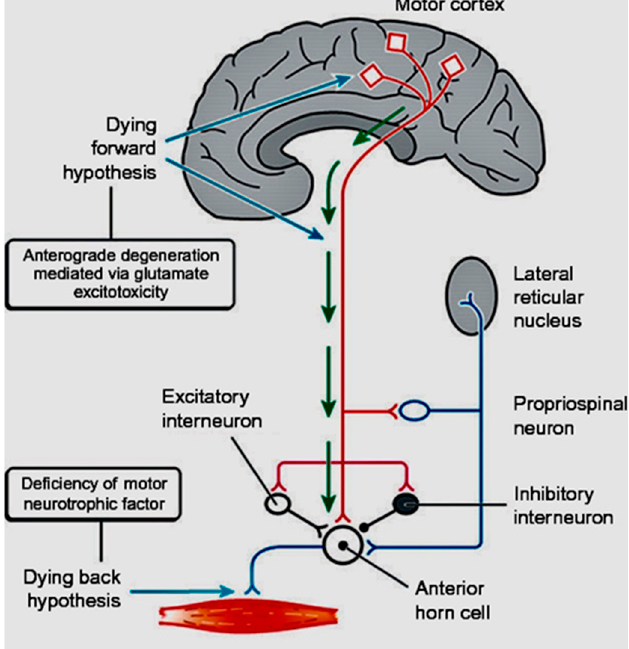
Figure 1. From Kiernan et al. [2]. The dying-forward hypothesis postulates that ALS commences in the motor and pre-motor cortices’ pyramidal neurons and, through antegrade mechanisms, causes dysfunction and death of the bulbar and spinal motor neurons. Excitotoxicity is important but not the only factor. The hallmark TAR DNA-binding protein 43 (TDP-43) pathology, seen in >95% of patients with ALS, is largely restricted to corticofugal projecting neurons (“dying forward”). In broader terms, this site of origin may be considered as the nidus of a spreading network disorder associated with frontotemporal dementia in ALS. In any event, ALS is best regarded as a degenerative brain disease. The figure indicates that there are alternative hypotheses of origin site which include dying-back and independent degeneration of the upper and lower motor neurons.